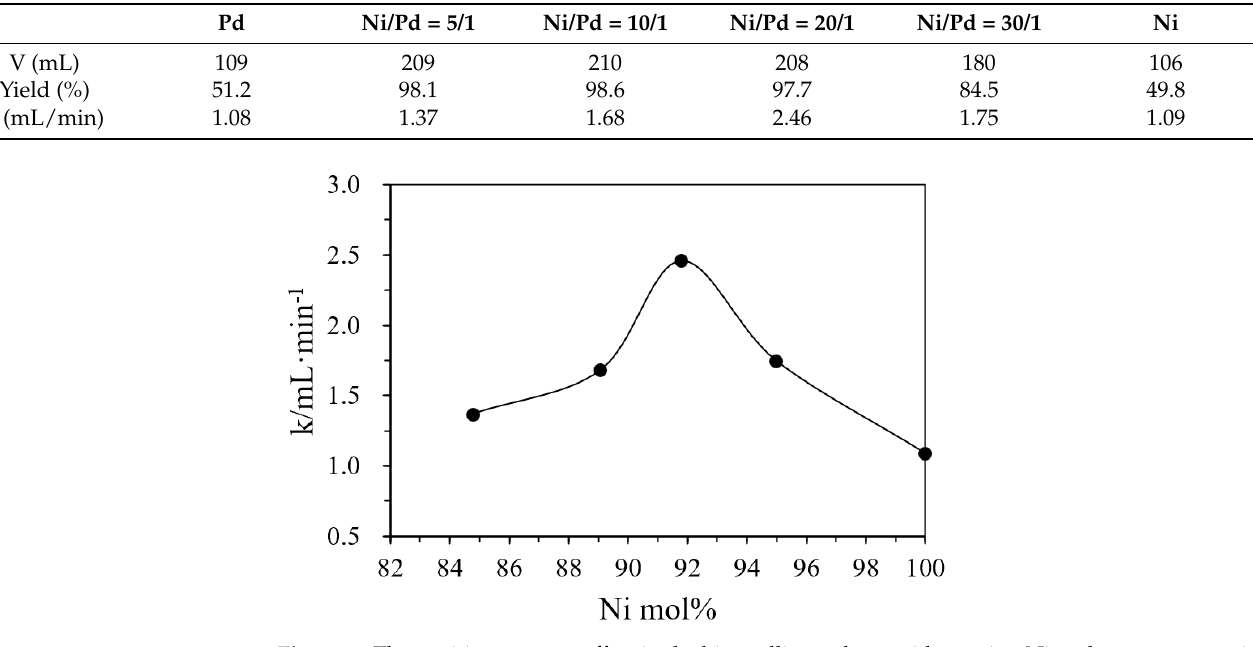
Figure 2. XPS spectrum of ( a ) Pd (3d) region and ( b ) Ni (2p) region in PVP–Ni/Pd (Ni/Pd = 20/1). Table 2. Hydrogen production yields and rates (k) by hydrogel catalysts with various ratios of Ni/Pd at 50 ◦ C.